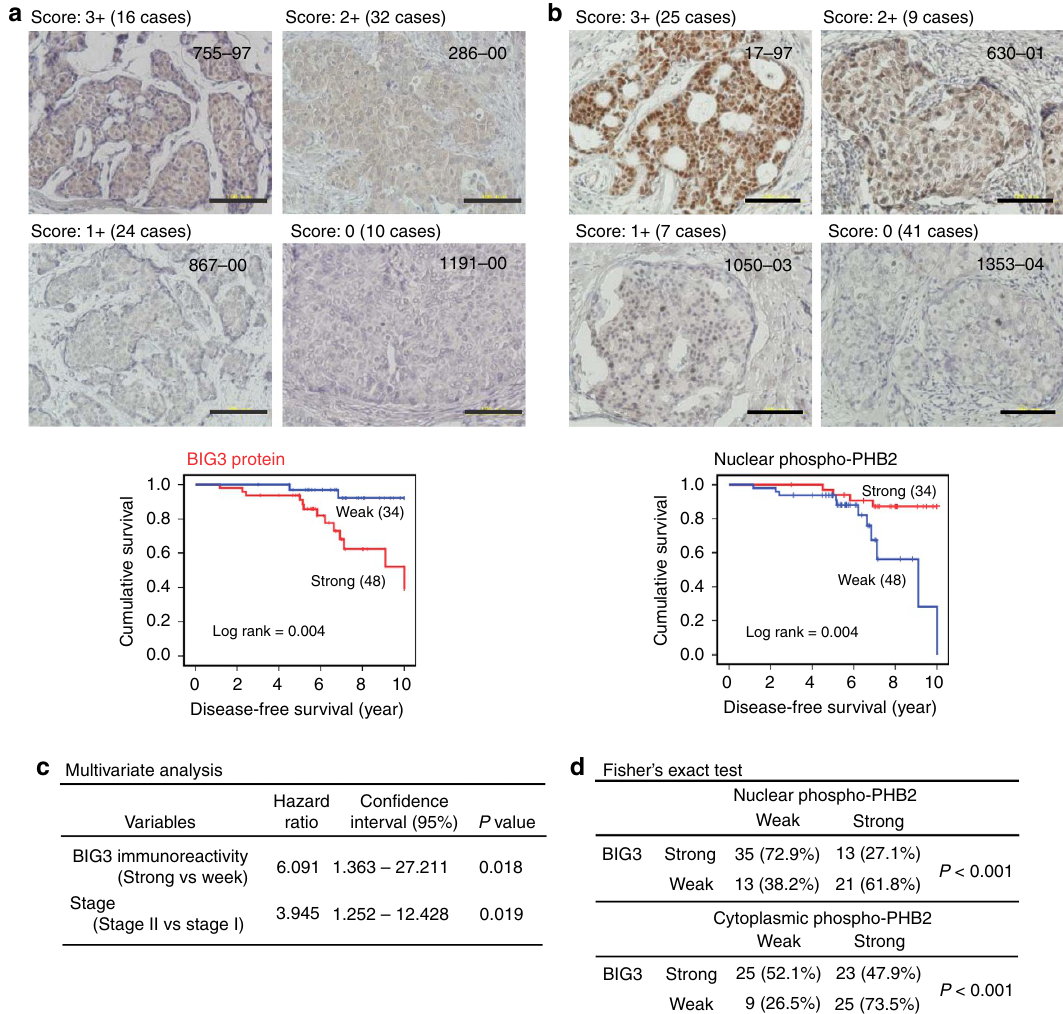
Figure 4 | BIG3 overexpression and PHB2 dephosphorylation status are strongly associated with poor prognosis. ( a , b ) Immunohistochemical staining (upper) and Kaplan–Meier analysis (lower) of survival associated with BIG3 protein ( a ) and nuclear PHB2 phosphorylation at S39 ( b ) in representative ER a -positive breast cancer specimens. ( c ) BIG3 protein expression, showing an independent prognostic significance in the multivariate Cox regression analysis. ( d ) Reverse correlation of BIG3 expression with PHB2 phosphorylation status at S39 according to Fisher’s exact test. For overall survival analysis, the log-rank (Mantel-Cox) test was used to determine the statistical difference between stratified